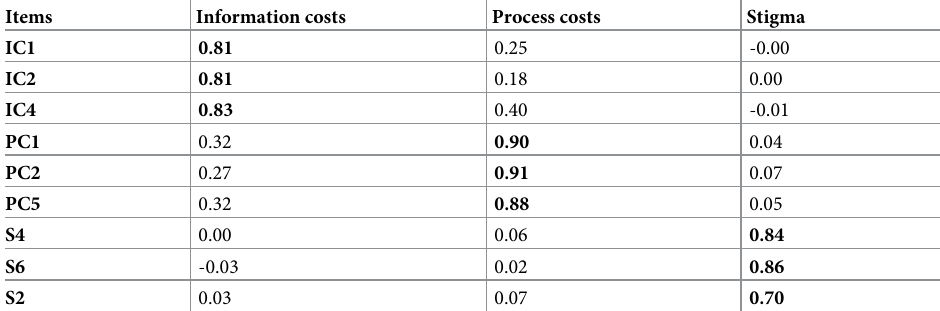
Table 4. Item-convergent validity: Item-scale correlation matrix for the three subscales of the CCS (Sample 2, n = 1265).